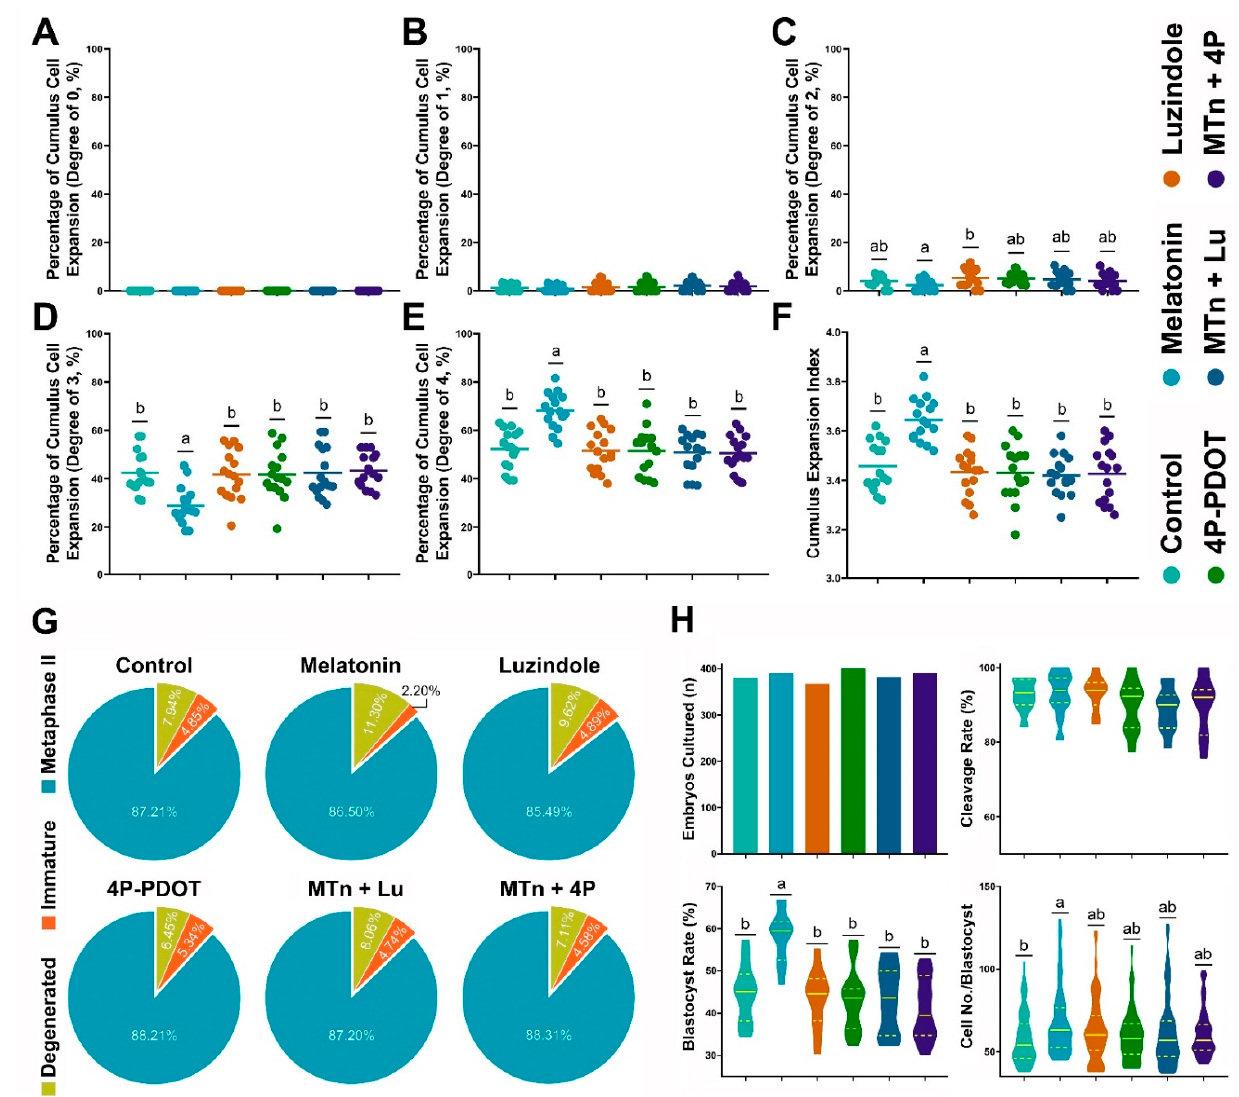
Figure 1. Effects of melatonin on cumulus cells expansion, nuclear maturation and embryo development after parthenogenetic activation. ( A – F ) Cumulus expansion index. ( G ) Oocyte nuclear maturation. ( H ) Embryo development. Melatonin/MTn, 10 − 9 mol/L melatonin; Luzindole/Lu, 10 − 9 mol/L Luzindole; 4P-PDOT/4P, 10 − 9 mol/L 4P-PDOT. Different letters denote a significant difference ( p <